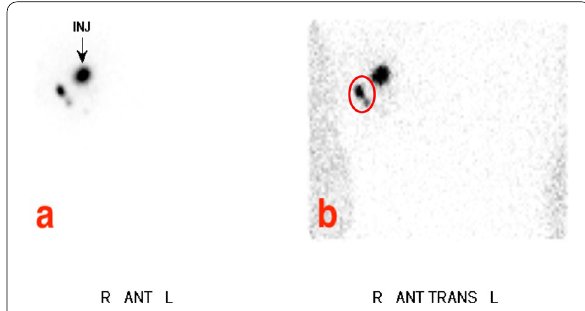
Fig. 9 Preoperative lymphoscintigraphy images, Case 7